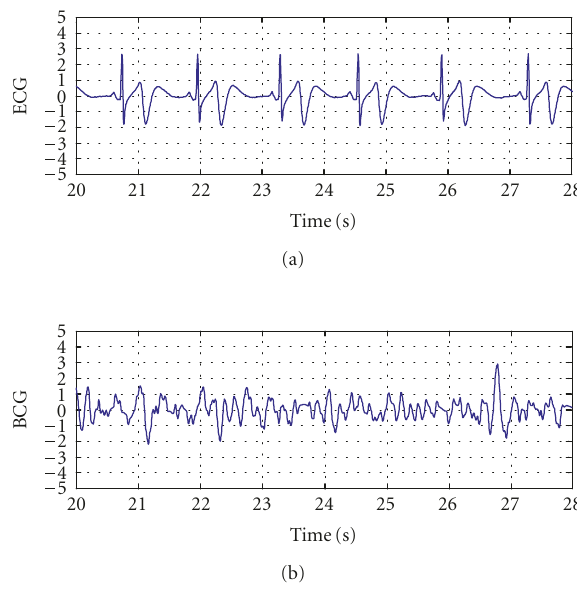
Figure 3: Typical ECG and BCG records of a normal subject.